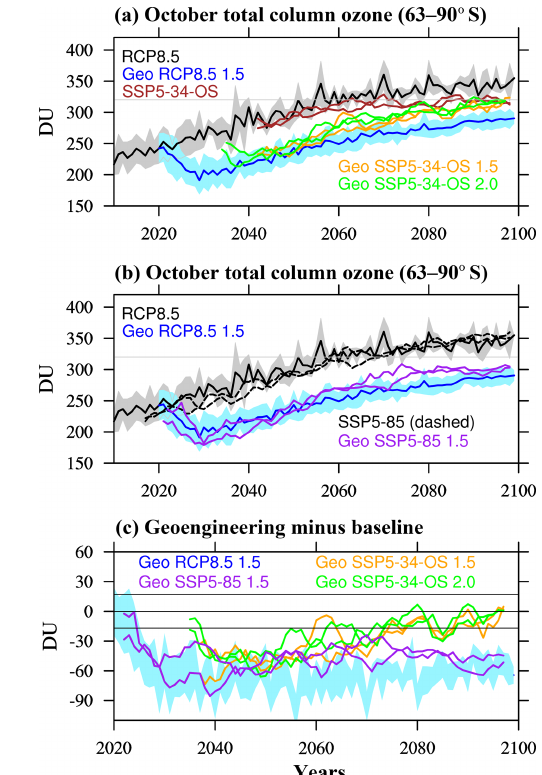
Figure 11. October averaged total column ozone between 63 and 90 ◦ S for different model experiments and ensemble members (dif- ferent colors) (a, b) . Grey and light blue areas show the standard deviation of the GLENS ensemble and the light grey line indicates 1980 values. (c) Differences between geoengineering and corre- sponding baseline experiments; the two black lines around zero in- dicate the standard deviation from the GLENS baseline